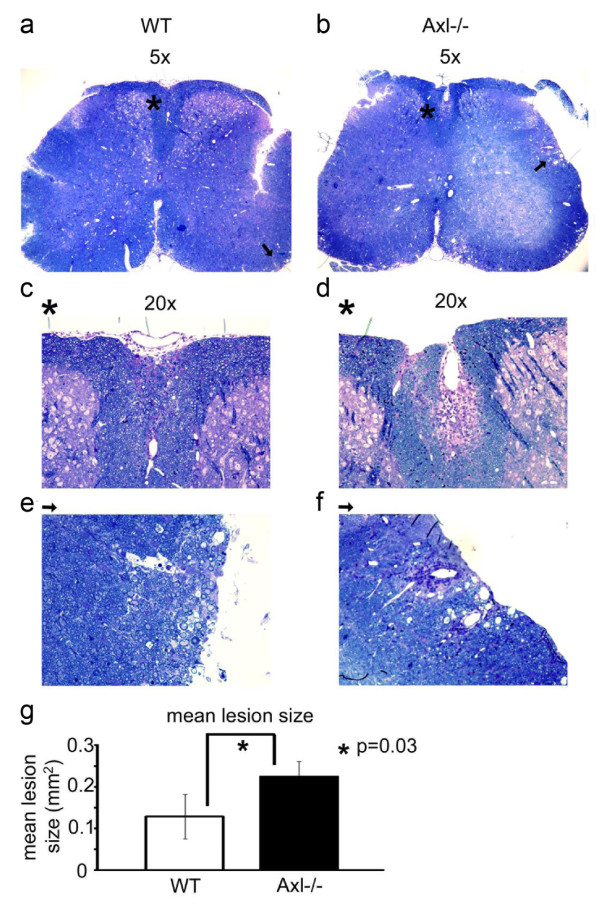
Axl-/- mice have larger inflammatory cuffs and increased demyelination in the spinal cord than WT mice. One micron Trump's fixed cross-sections of WT (a,c,e) and Axl-/- (b,d,f) spinal cords were stained with toluidine blue. a,b) Representative 5× sections of whole spinal cord. Two 20× sections with areas of infiltration and demyelination are shown for each 5× section (WT: c,e; Axl-/-: d,f). The 20× sections are labeled with an asterisk (dorsal funiculus; c,d) or arrow (lateral funiculus; e,f) denoting the corresponding area on the 5× section. g) quantitative data for the mean lesion size (mm2), see methods.  Ratio of CD3+ to Iba1+ cells per lesion.